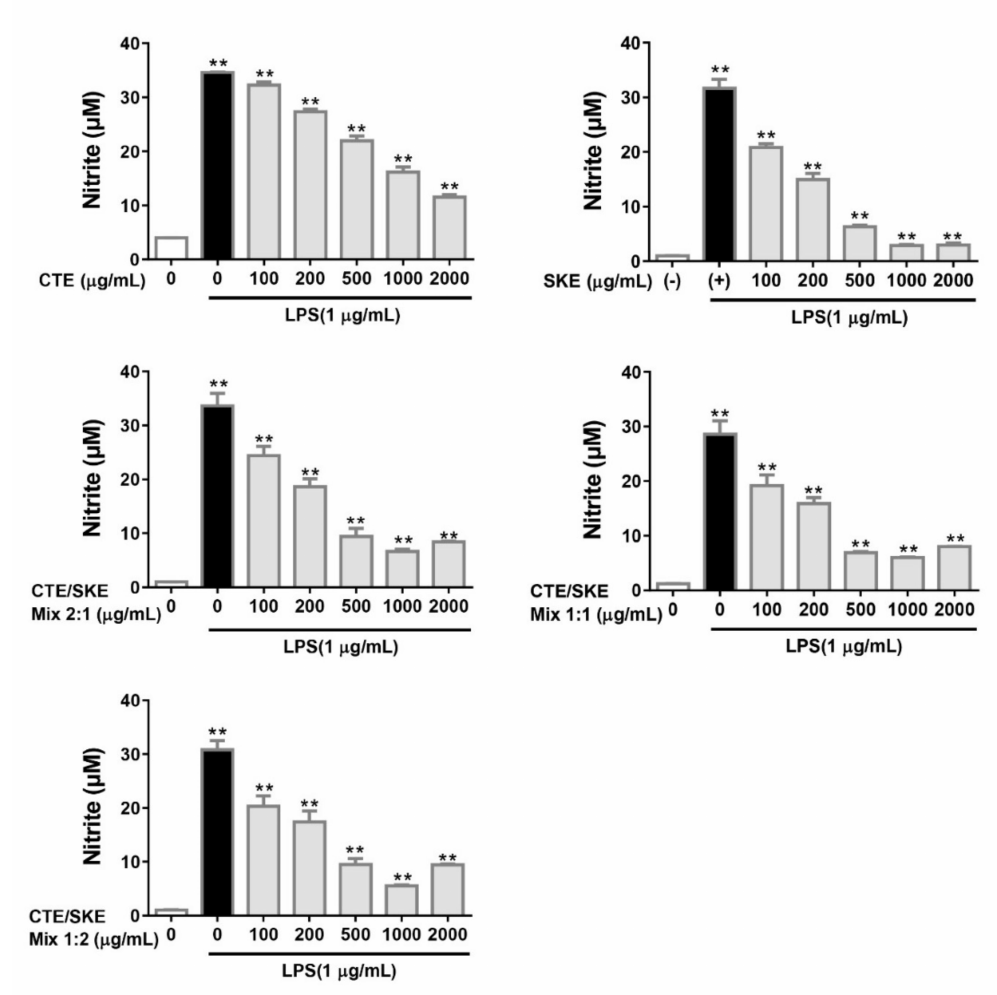
Figure 2. Effect of CTE and CTE mix on Nitric Oxide (NO) production in LPS induced RAW264.7 cells Inhibition of NO production results of CTE only; SKE only; and these two extracts mixed at ratios of 1:1, 1:2, and 2:1. The cells were treated with different concentrations (0, 100, 200, 500, 1000, and 2000 µ g/mL) of a mixture of CTE and SKE in various ratios. Simultaneously, 1 µ g/mL of LPS was added and incubated for 24 h. The ELISA reader at an absorbance of 540 nm. (Control vs. ** p <